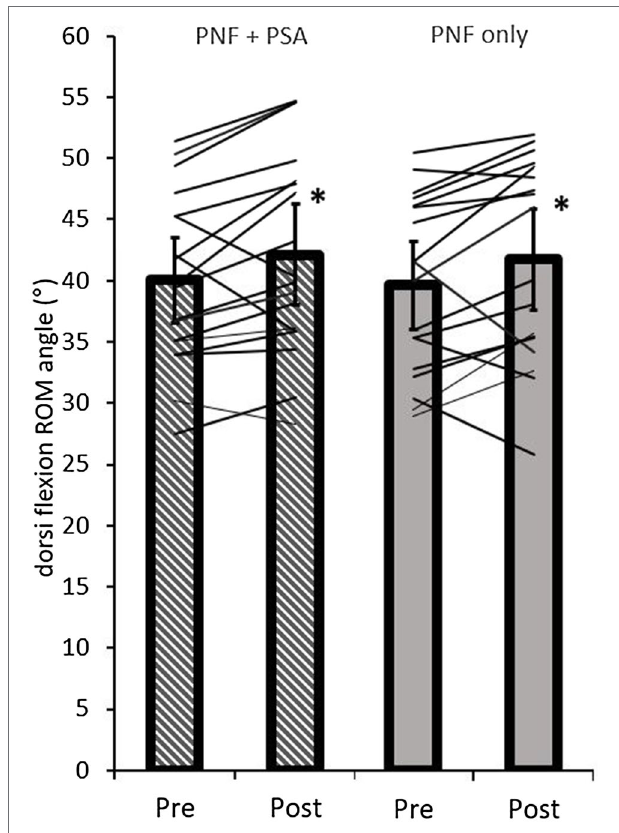
FIGURE 7 | Pre- and post-dorsiflexion ROM values of both groups (PNF only and PNF + PSA) and the individual changes. * = significant changes between pre- and